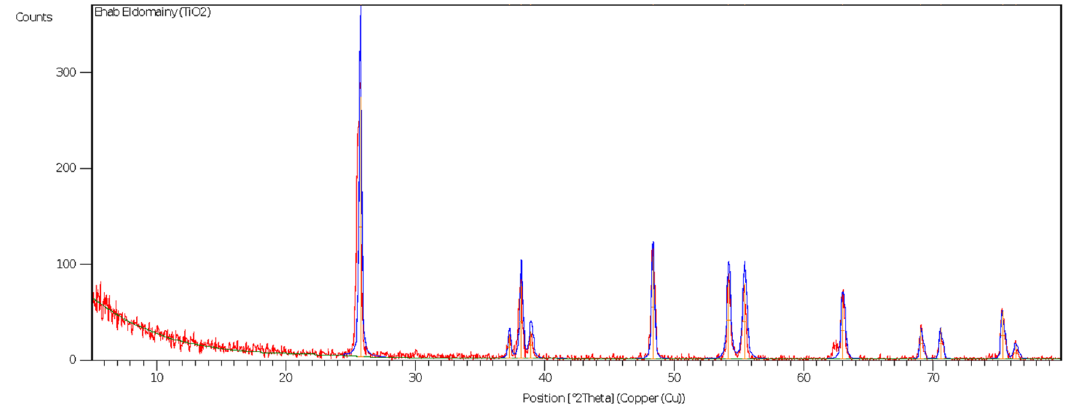
Figure 1. Characterization of TiO 2 nanoparticles, X-ray diffraction (XRD) peak of crystalline powder of TiO 2